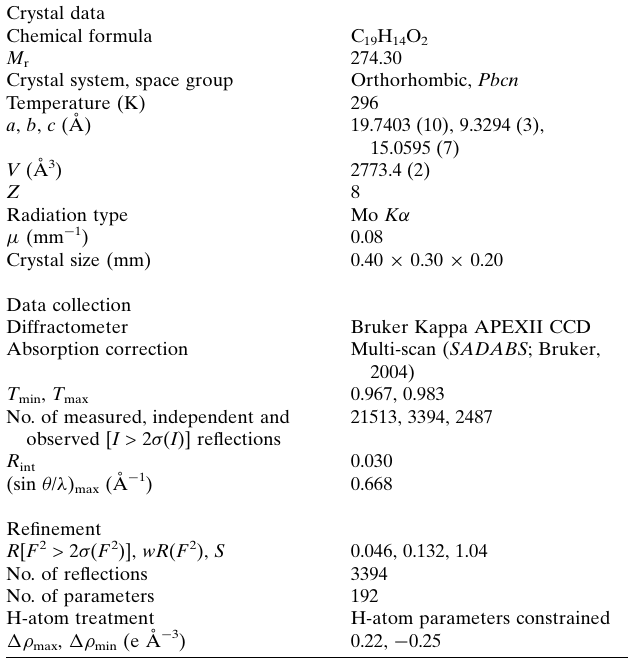
Table 2 Experimental